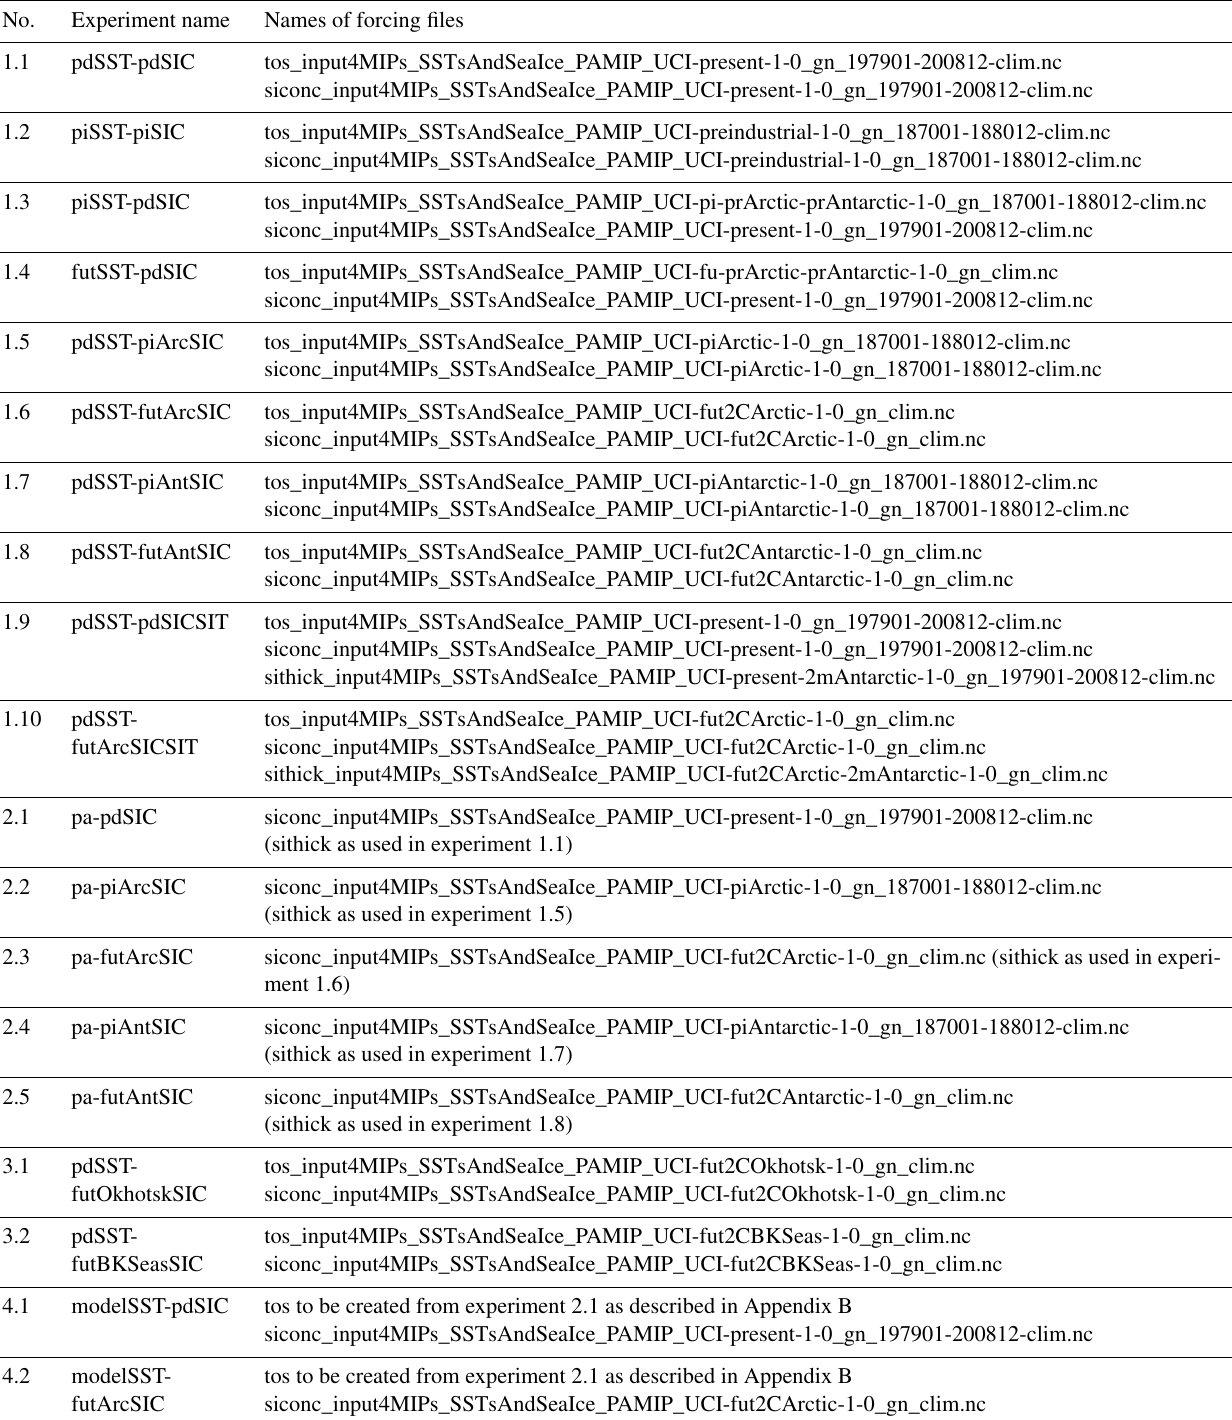
Table A1. Names of forcing files for each experiment. Files are available from the input4MIPs data server (https://esgf-node.llnl.gov/search/ input4mips/last access: 20 March 2019). Comments in square brackets are optional guidance for groups that are able to constrain sea ice thickness